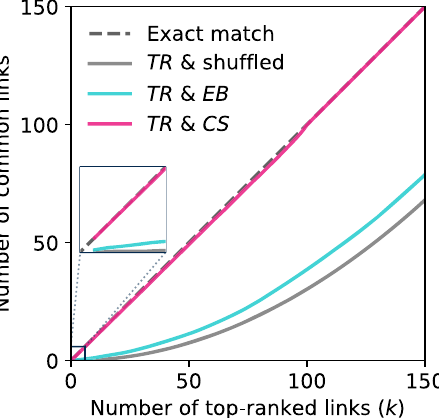
Fig. 4 Assessing the accuracy of link criticality score index in identifying the true bottlenecks. The true ranking of links (TR) in terms of their improvement effect on network reliability α , is compared to rankings based on link criticality score (CS), edge betweenness centrality (EB), and randomly shuf fl ed rankings of links. Each curve shows the number of common links between the set of top- k true bottlenecks and top- k bottlenecks of another ranking scheme. A ranking equal to TR leads to a line lying on the diagonal dashed